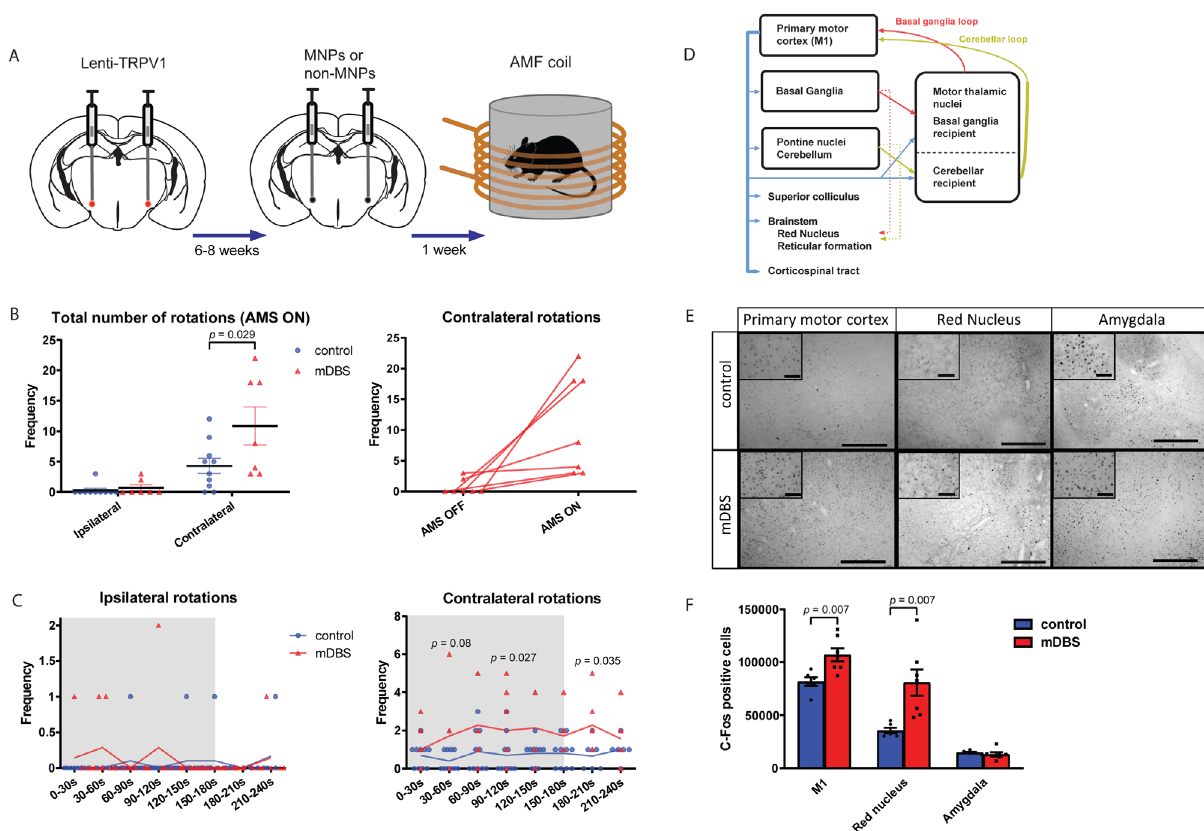
Fig. 2 Remote magnetothermal neuromodulation of mouse behavior. A In vivo experimental scheme. B Total rotations of STN mDBS ( n = 7) and control animals ( n = 10) during AMF ON and OFF conditions. Data presented as mean ± S.E.M., one-tailed t -test, t(15) = 2.052, p = 0.029. C Rotational behavior presented in 30 s time bins. Shaded areas indicate when AMF was on. Repeated-measures ANOVA indicated a signi fi cant effect between groups for contralateral rotations (F(1,15) = 6.307, p = 0.024, C ). One-tailed t -tests revealed the signi fi cant difference between mDBS and control mice with regard to contralateral rotations around the body axis within the time intervals of 30 – 60 s (t(15) = 2.703, p = 0.008), 90 – 120 s (t(15) = 2.078, p = 0.027) and 180 – 210 s (t(15) = 2.066, p = 0.035) when the coil was already turned off. No signi fi cant difference was seen in ipsilateral rotations around the body axis (t(15) = 0.755, n.s.). D Major central nervous system regions involved in control of the motor system (adapted from ref. 50 ). The primary motor cortex and brainstem reticular formation, which serve as the origin of the descending rubrospinal and reticulospinal tracts. Axonal collaterals target structures including the pontine nuclei, the superior colliculus, the basal ganglia, and the thalamus. Basal ganglia (red) and cerebellum (gold) form two major loops which can in fl uence M1 and thus motor function. E Representative low-power photomicrographs (scale bar = 1000 µ m) of coronal brain sections stained for c-Fos (K-25) showing the primary motor cortex M1, red nucleus, and amygdala each with high-power photomicrograph insets in the upper left corner (scale bar = 50 µ m) in mice receiving STN mDBS ( n = 7) and controls ( n = 6). F Comparisons were made between STN mDBS ( n = 7) and control mice ( n = 6). STN mDBS animals showed increased Fos expression in motor areas such as M1 and the red nucleus, whereas the amygdala, a non-motor area, was not affected. Data presented as mean ± S.E.M., two-tailed independent samples t -test, M1: t(11) = 3.338; p = 0.007; red nucleus: t(11) = 3.293; p = 0.007; amygdala: t(11) = 0.771; n.s. Source data are provided as a Source data fi computational model (Supplementary Materials Table S1, Figs.